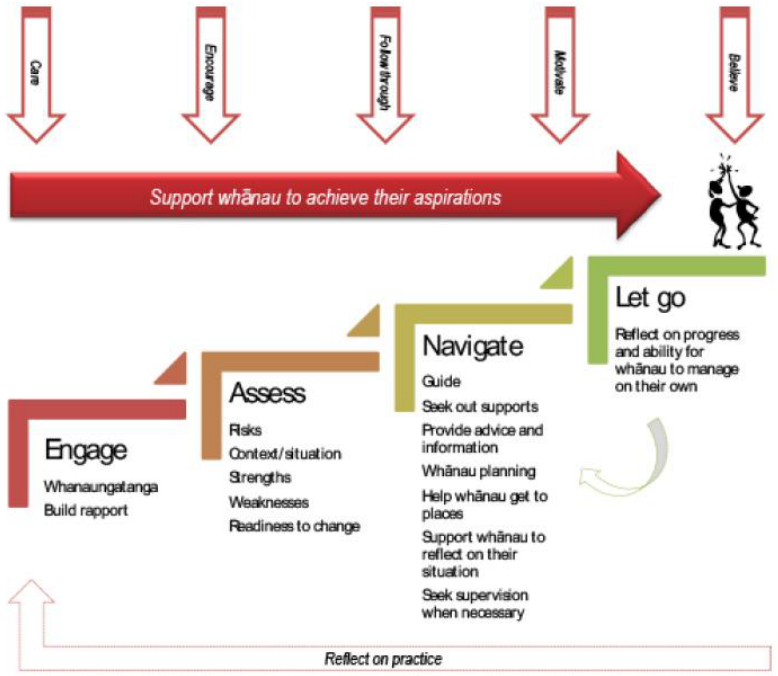
Figure 4. The navigational approach of Whānau ora navigators (reproduced with permission); taken from [44] .